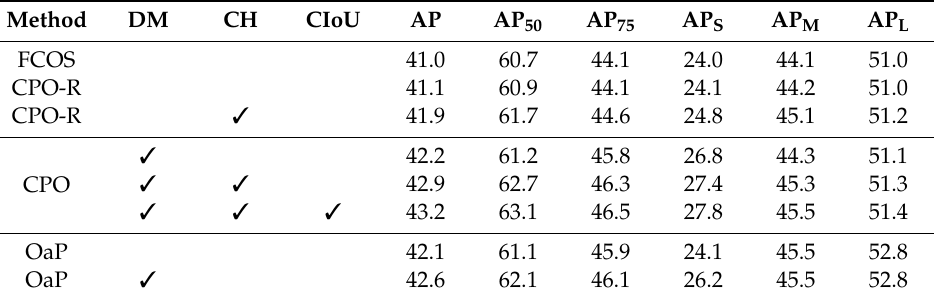
Table 3. Ablation results (DM: di ff erentiation module, CH: